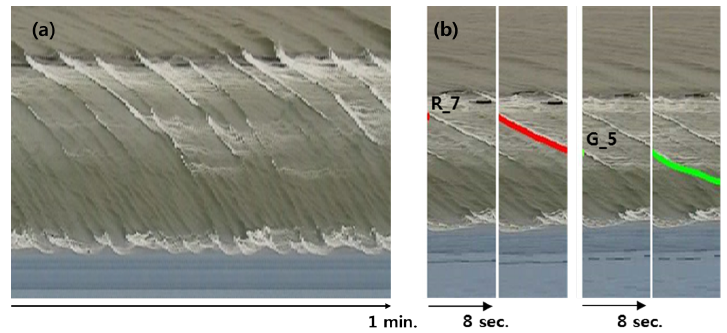
Figure 9. ( a ) Timestack images along the transect connecting R_7 and R_5 for 1 min. with 1800 frames in Figure 8 with 10 frames interval and ( b ) tracked two landmarks of R_7 and G_5 in the timestack images for 8 s.